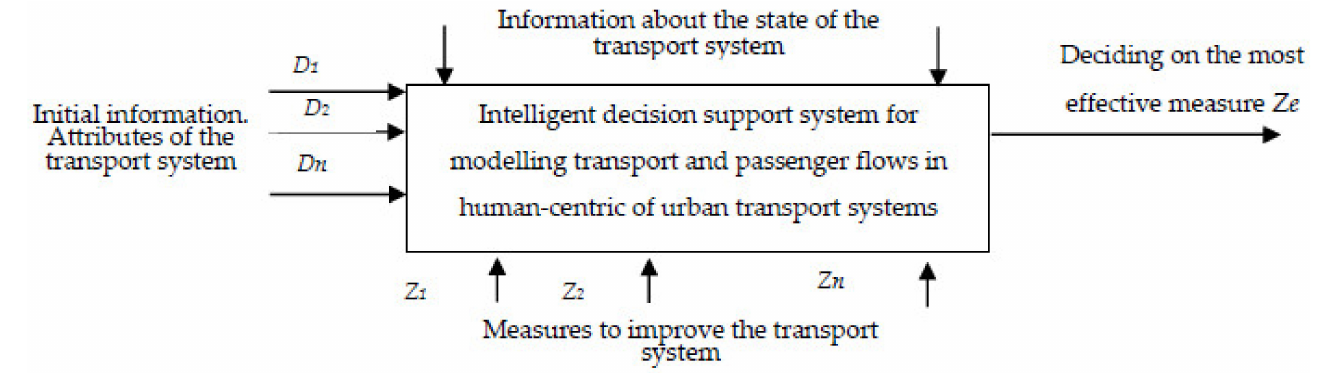
Figure 2. General scheme of intelligent decision support system for modeling passenger and transport flows in human-centric urban transport